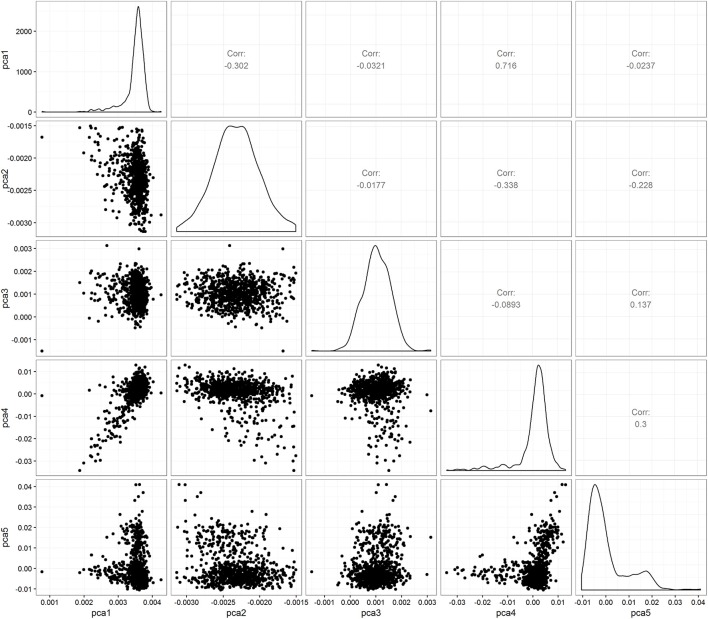
Pairwise PC plots within 624 Caucasian patients with AML.